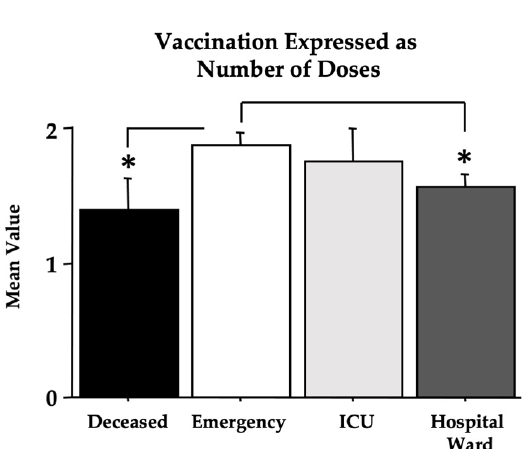
Figure 7. Ferritin in recruited women and men (and relative reference ranges). The error bars indi ‐ cate the pooled standard error means (SEM) derived from the appropriate error mean square in the ANOVA. The asterisks (* p < 0.05) indicate post hoc differences between groups.